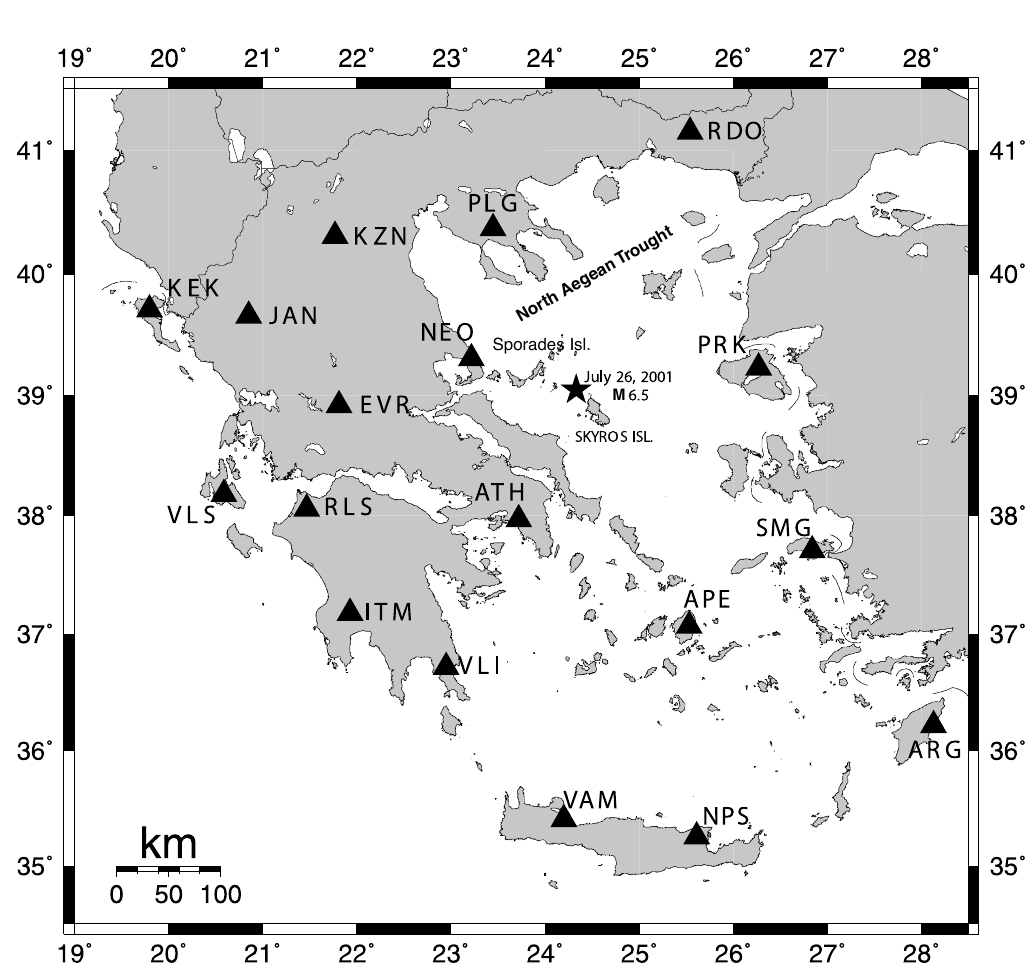
Fig. 1. Regional map showing the sites of the broadband stations, operated by the Geodynamic Institute of the National Observatory of Athens, and the epicentre location (asterisk) of the Skyros July 26, 2001